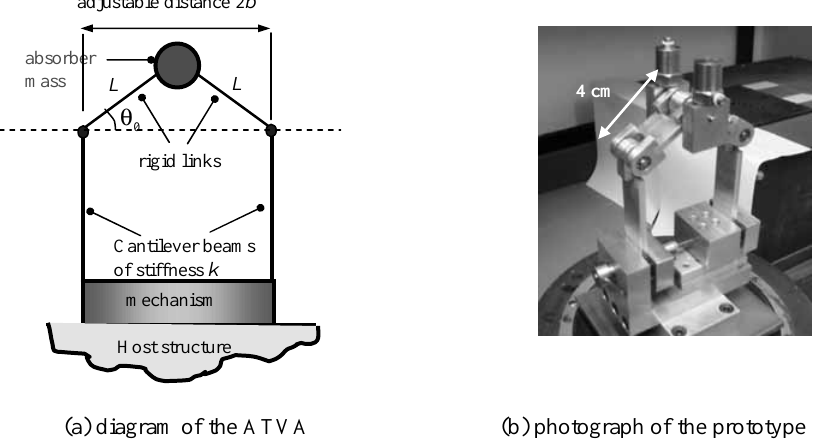
Fig. 7. Alternative design of an ATVA using shape change to realise a variable stiffness element.